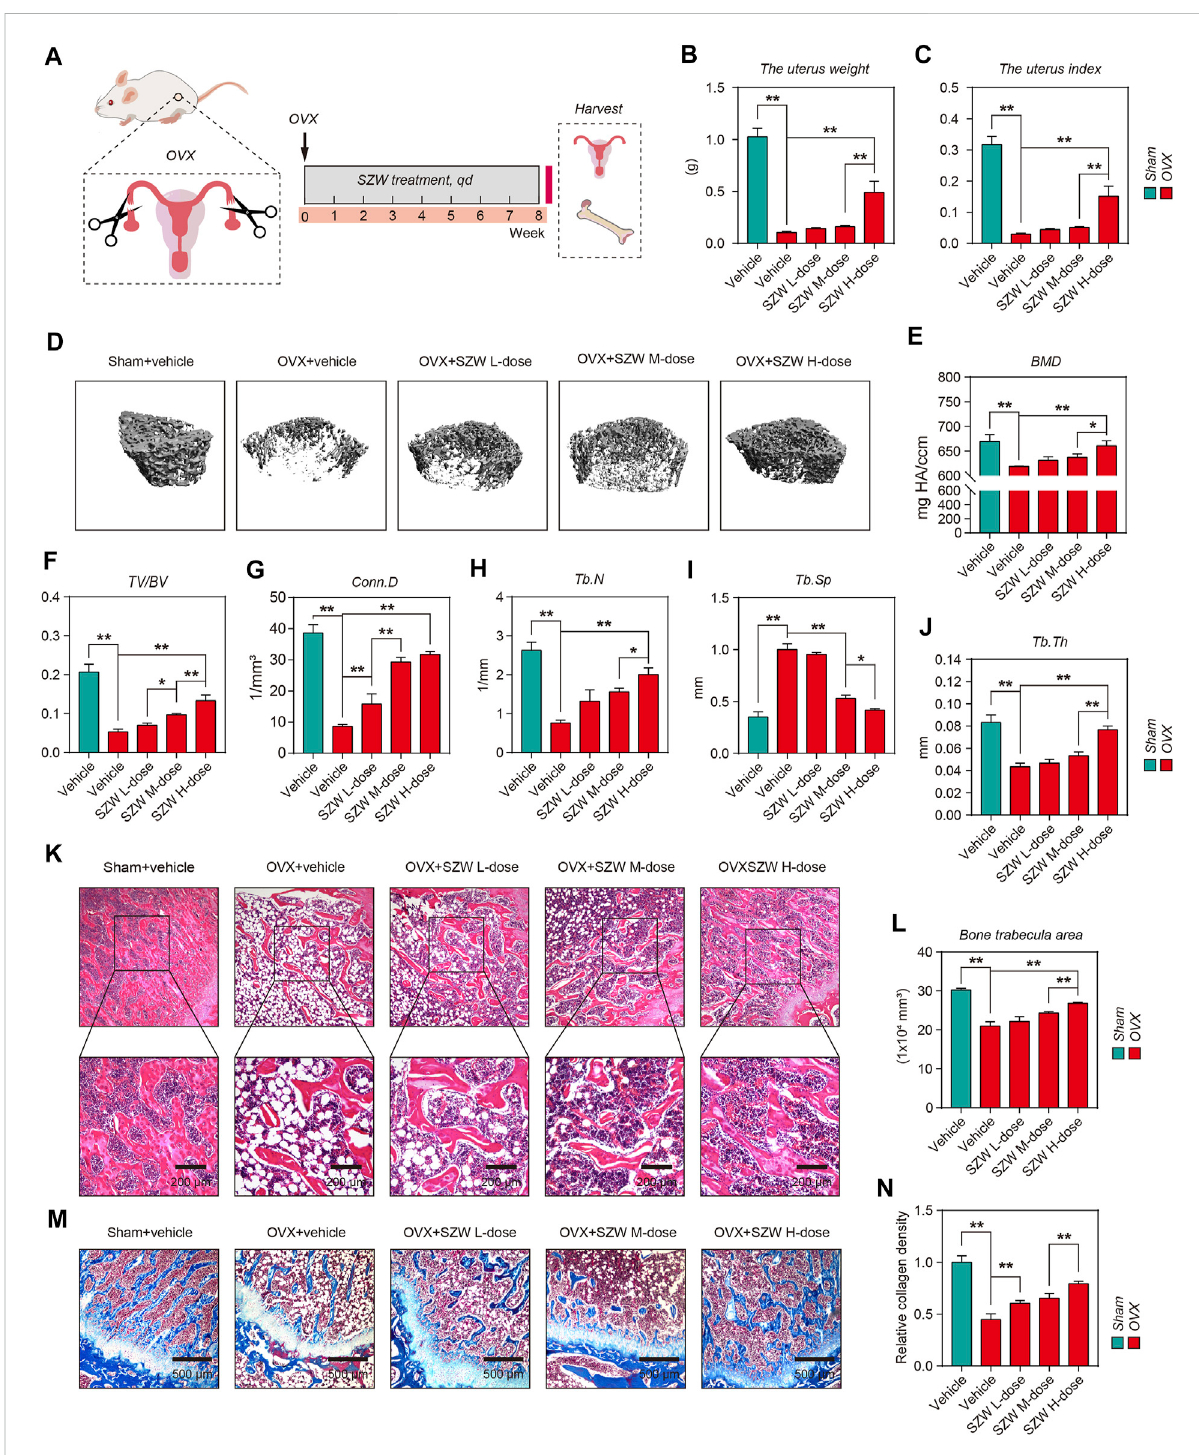
FIGURE 1 SZW ameliorated ovariectomy-induced bone loss in rats (A) Schematic diagram of the in vivo experiments (B) The weight of uterus in each group (C) The uterus index of rats in each group (D) Representative μ CT images of femur bone (E – J) Quantitative analyses of parameters of bone microstructure and cortical bone, including BMD, BV/TV, Conn. D, Tb.N, Tb. Sp, and Tb.Th (K) Representative H&E staining of femur sections in different groups after OVX (L) The quantitative analysis of bone trabecula area (M) Representative Masson ’ s trichrome staining of the femur sections (N) Relative collagen density was quanti fi ed using ImageJ. Data are presented as the mean ± SEM (n = 6). * p < 0.05, ** p < 0.01. BMD, bone mineraldensity;BV/TV,bonevolumepertissuevolume;Conn.D,connectivitydensity;Tb.N,trabecularnumber;Tb.Sp,trabecularseparation;Tb.Th, trabecular thickness; ns, non-signi fi